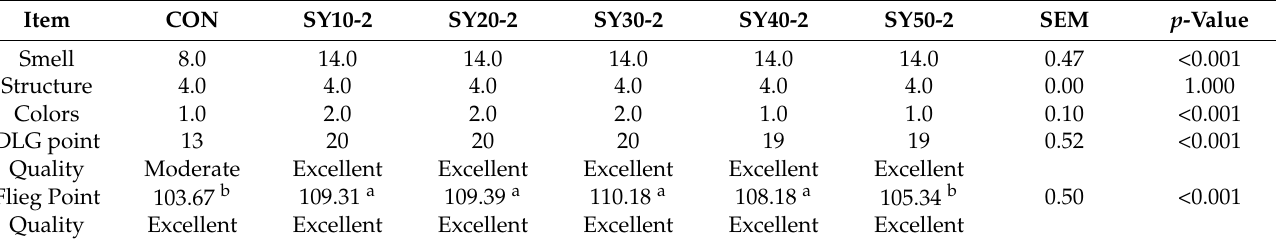
Table 1. The effects of different yogurt levels on silage qualities ( n =